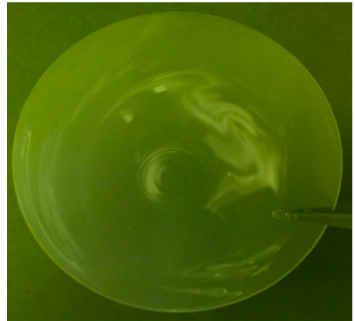
Figure 2. Visible striations in unpatterned four inch diameter wafer after bake and etch processes.